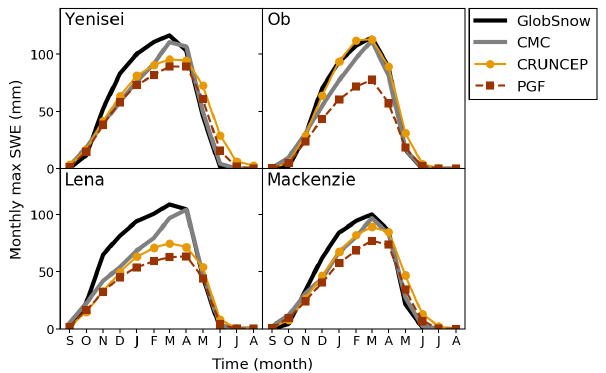
Figure 7. Climatology of monthly maximum SWE (mm) from ob- servations and from the UCC model runs for the common overlap period, 2002–2010.